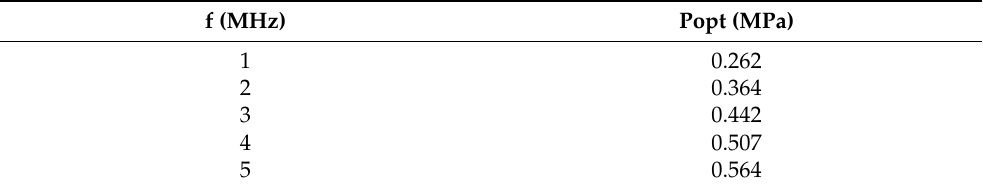
Figure 3. Plot of the cavitation threshold in water as a function of initial nucleus radius for three frequencies ultrasound: 1, 5, and 10 MHz [35]. Table 1. Minimum cavitation threshold Popt at different ultrasound frequency